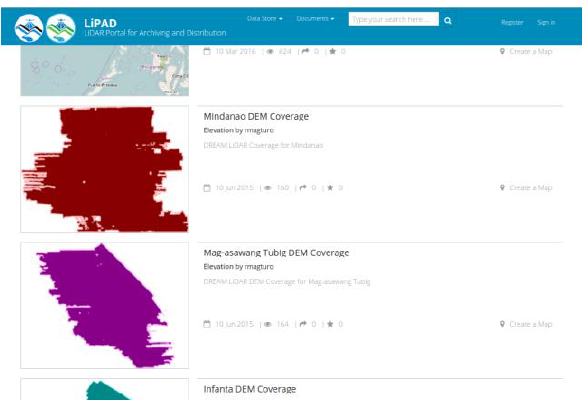
Figure 6. Vector Based DEM Data Coverage in